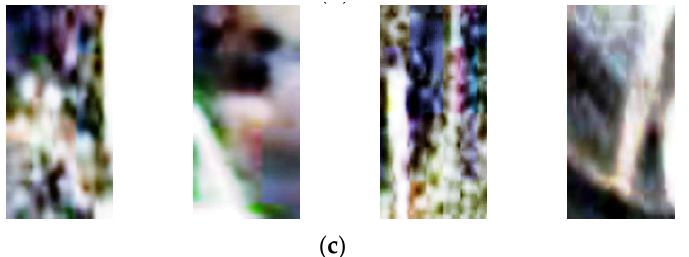
Figure 8. Examples of FN and FP errors in cases using HE processed images of ( a ) CVC-14 database;